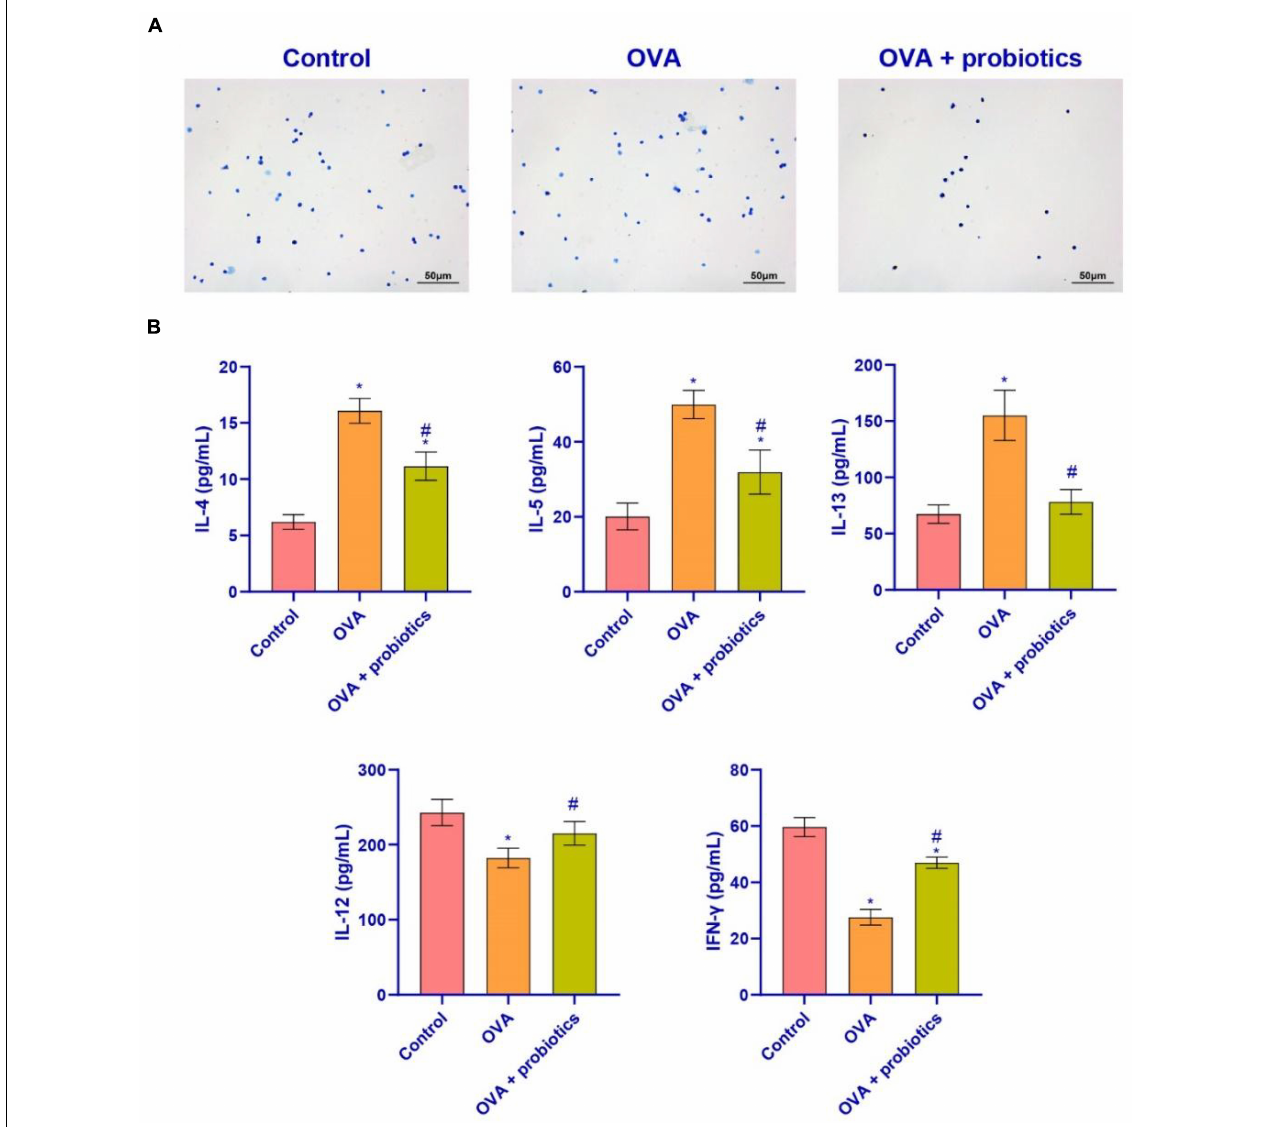
FIGURE 4 | Lactobacillus ferokay smentum CECT5716 might inhibit the level of pro-inflammatory factors in BALF. (A) Wright’s staining ( × 200, scale bar = 50 µ m). (B) ELISA was used to measure the level of inflammatory factors. Expression levels of inflammatory factors (IL-4, IL-5, IL-13, IL-12, and IFN- γ ). *Compared with the control group, P < 0.05. # Compared with the OVA group, P < 0.05. One-way ANOVA was used among multiple groups. n = 5 for each